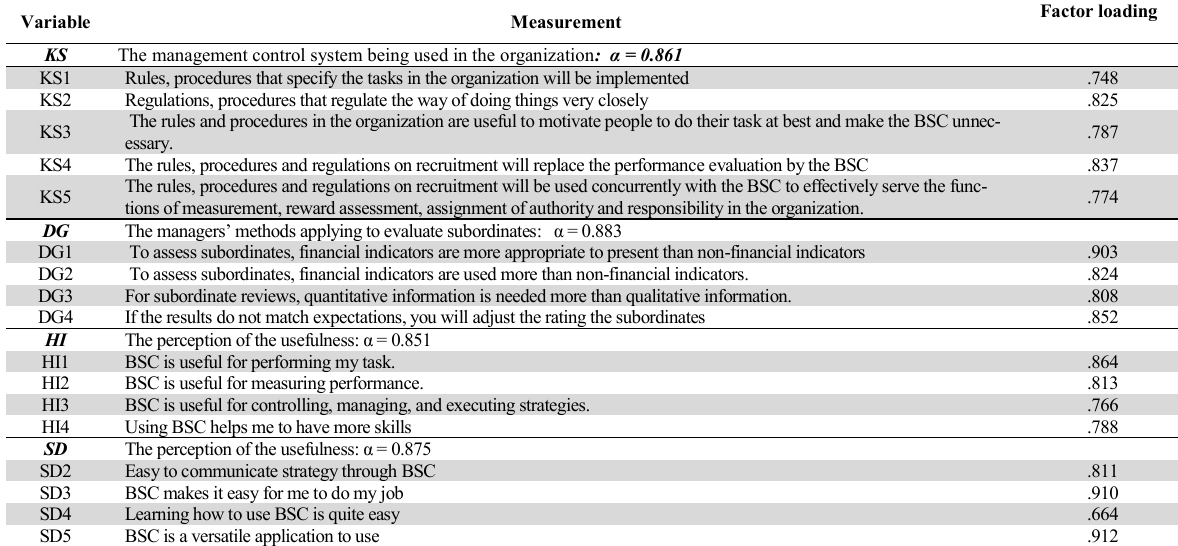
Summary of the results of independent